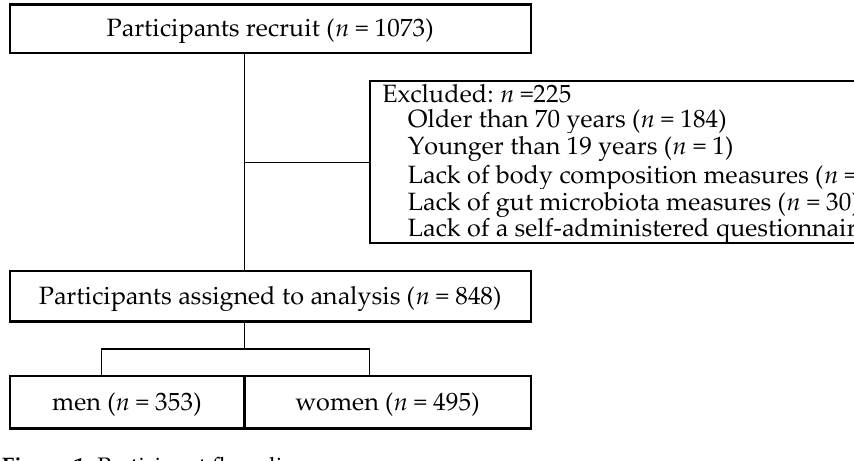
Figure 1. Participant flow diagram.